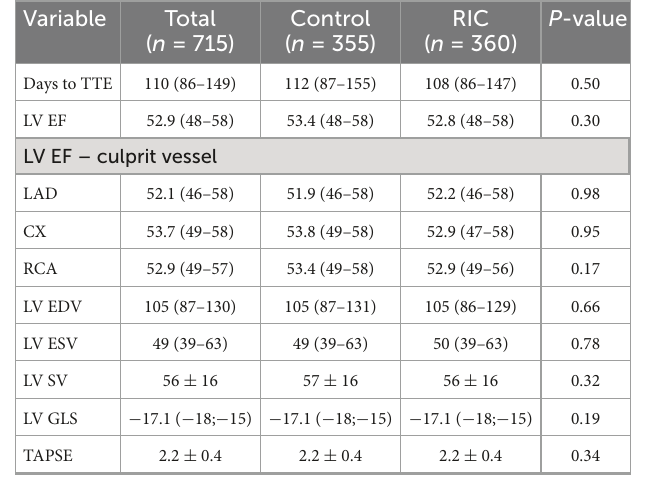
TABLE 2 Echocardiography results at follow-up following myocardial infarction.